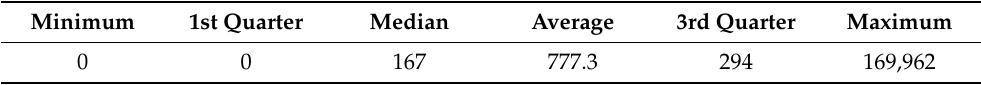
Table 4. Statistical analysis for general network